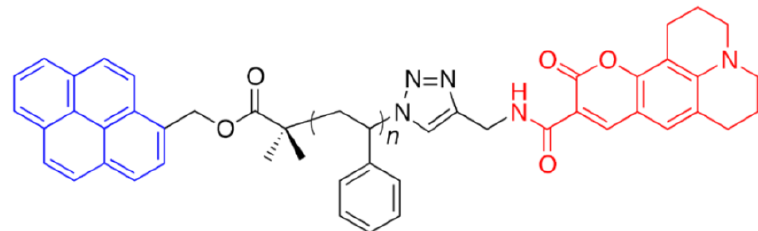
Figure 1. Chemical geometries of Pyr-PSt-C343.